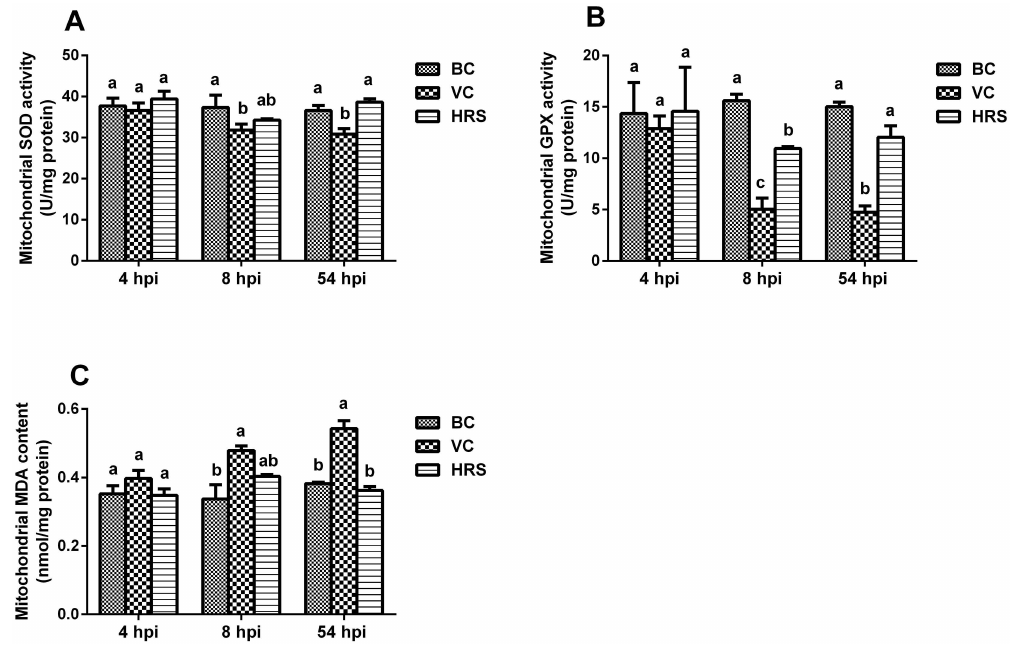
Fig 5. Changes of the mitochondrial peroxidation injury indexes at 4 hpi, 8hpi and 54 hpi (hpi: Hours Post- Injection). Liver tissue samples were obtainedfrom individual ducklingsof each group at the indicatedtime points to isolate mitochondria. Then the mitochondrial SOD (A), GPX (B) activities and MDA (C) content were detected with corresponding assay kit. a-c Bars in the same index at the same time point without the same superscripts differ significantly ( p <